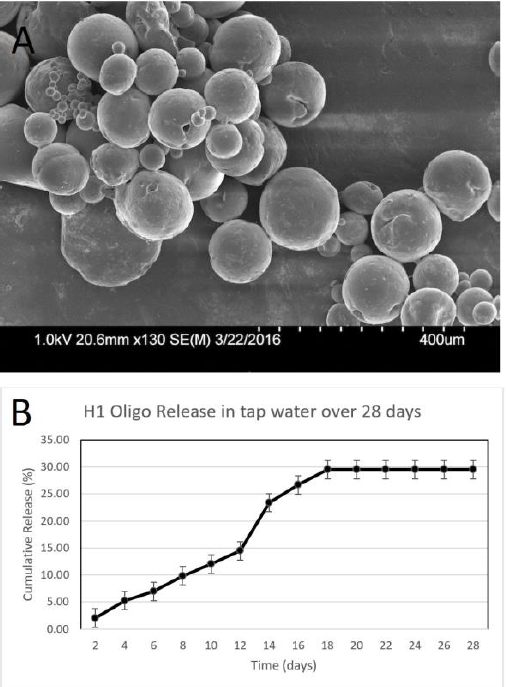
Figure 4. Characterization of H1 Oligo releasing microspheres. ( A ) Scanning electron microscopy images of microspheres. ( B ) Graph showing the cumulative release of the H1 DNA probe over 28 days representing the cumulative standard deviation at each time interval ( n = 3).